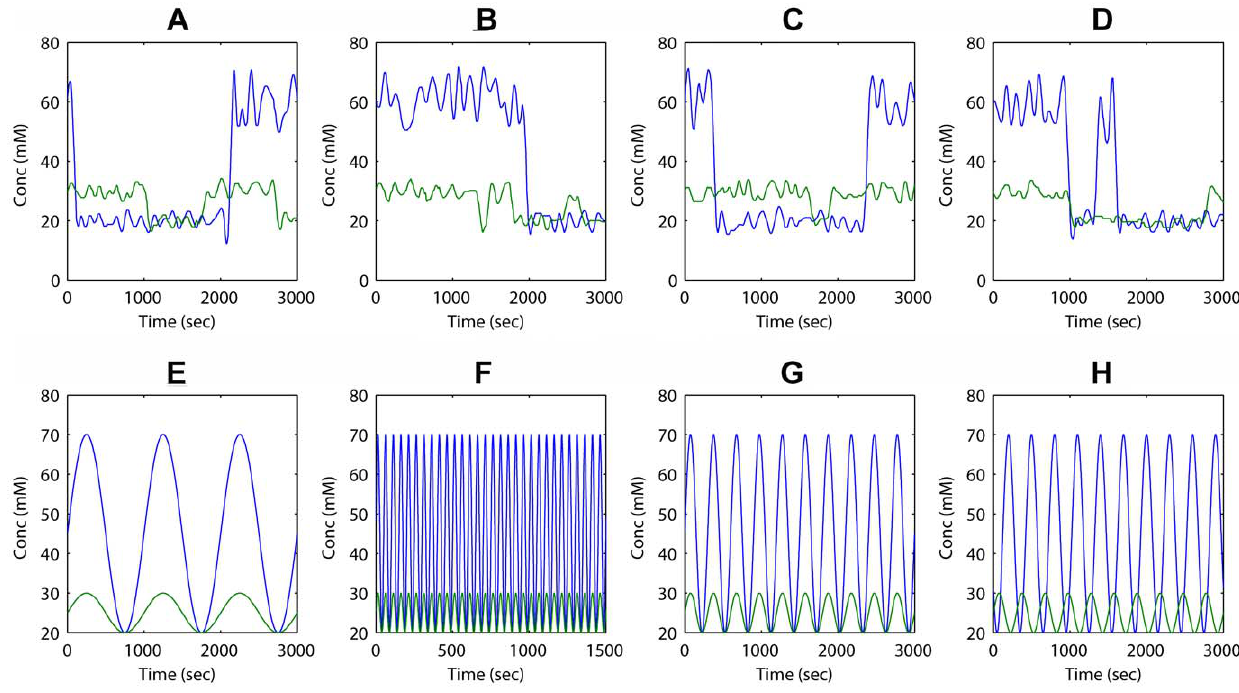
Figure 2. Time (sec) courses of external variations of concentrations (mM) of F (in blue) and T (in green). The first four courses a–d (A–D) are taken from figure 4 of [17] labeled as I, II, III and IV. The other four courses e–h (E–H) are obtained through the following sinusoidal equations: F ~ a 1 sin((2 p = T ) t z Q z ( a 1 z min F ) and T ~ a 2 sin((2 p = T ) t z ( a 2 z min T ) , where a 1 and a 2 are the amplitudes, t is the time, T the period, Q the phase and min F and min T are the minimum values of F and T . The first two ( e and f ) differ in their period but have the same phase ( Q =0); course e presents a high period ( T =1000) while course f presents a lower one ( T =50). The two last sinusoidal courses ( g and h ) differ from each other in phase (for course g , Q =0 and for course h , Q =10) and from the other two in period ( T =300). The concentrations of the reservoir species F and T vary within two regimes. For F centred at 60 mM and 30 mM and for T at 30 mM and 20 mM.